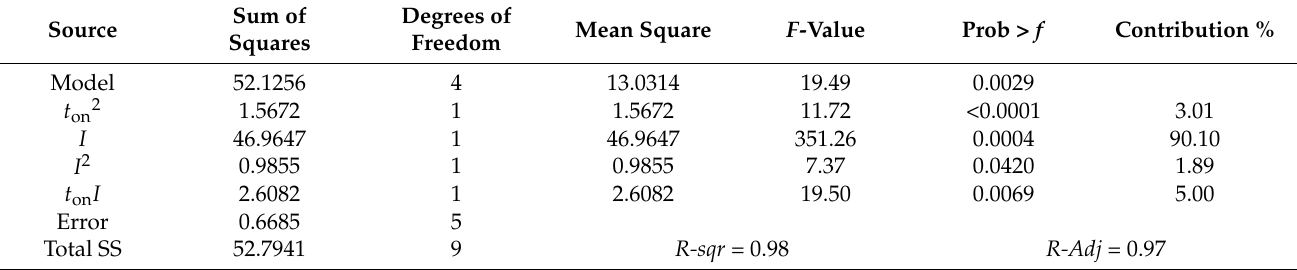
Table 6. ANOVA table for Ra (after elimination).